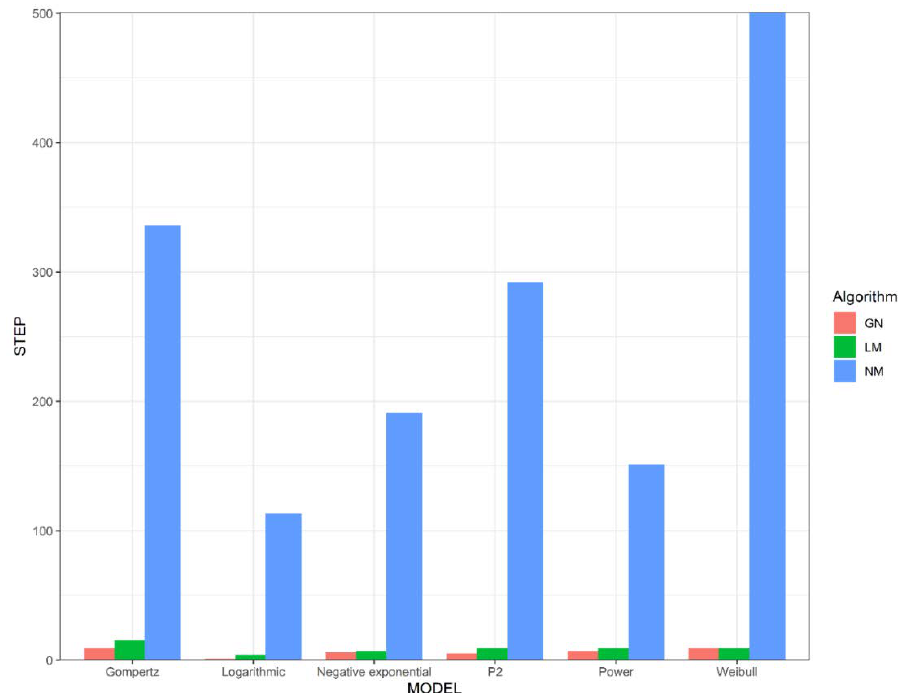
Figure 1. The number of steps required for the algorithms to iterate from the initial parameters x 0 to x T . GN represents the Gauss–Newton method, LM represents the Levenberg–Marquardt method, and NM represents the Nelder–Mead